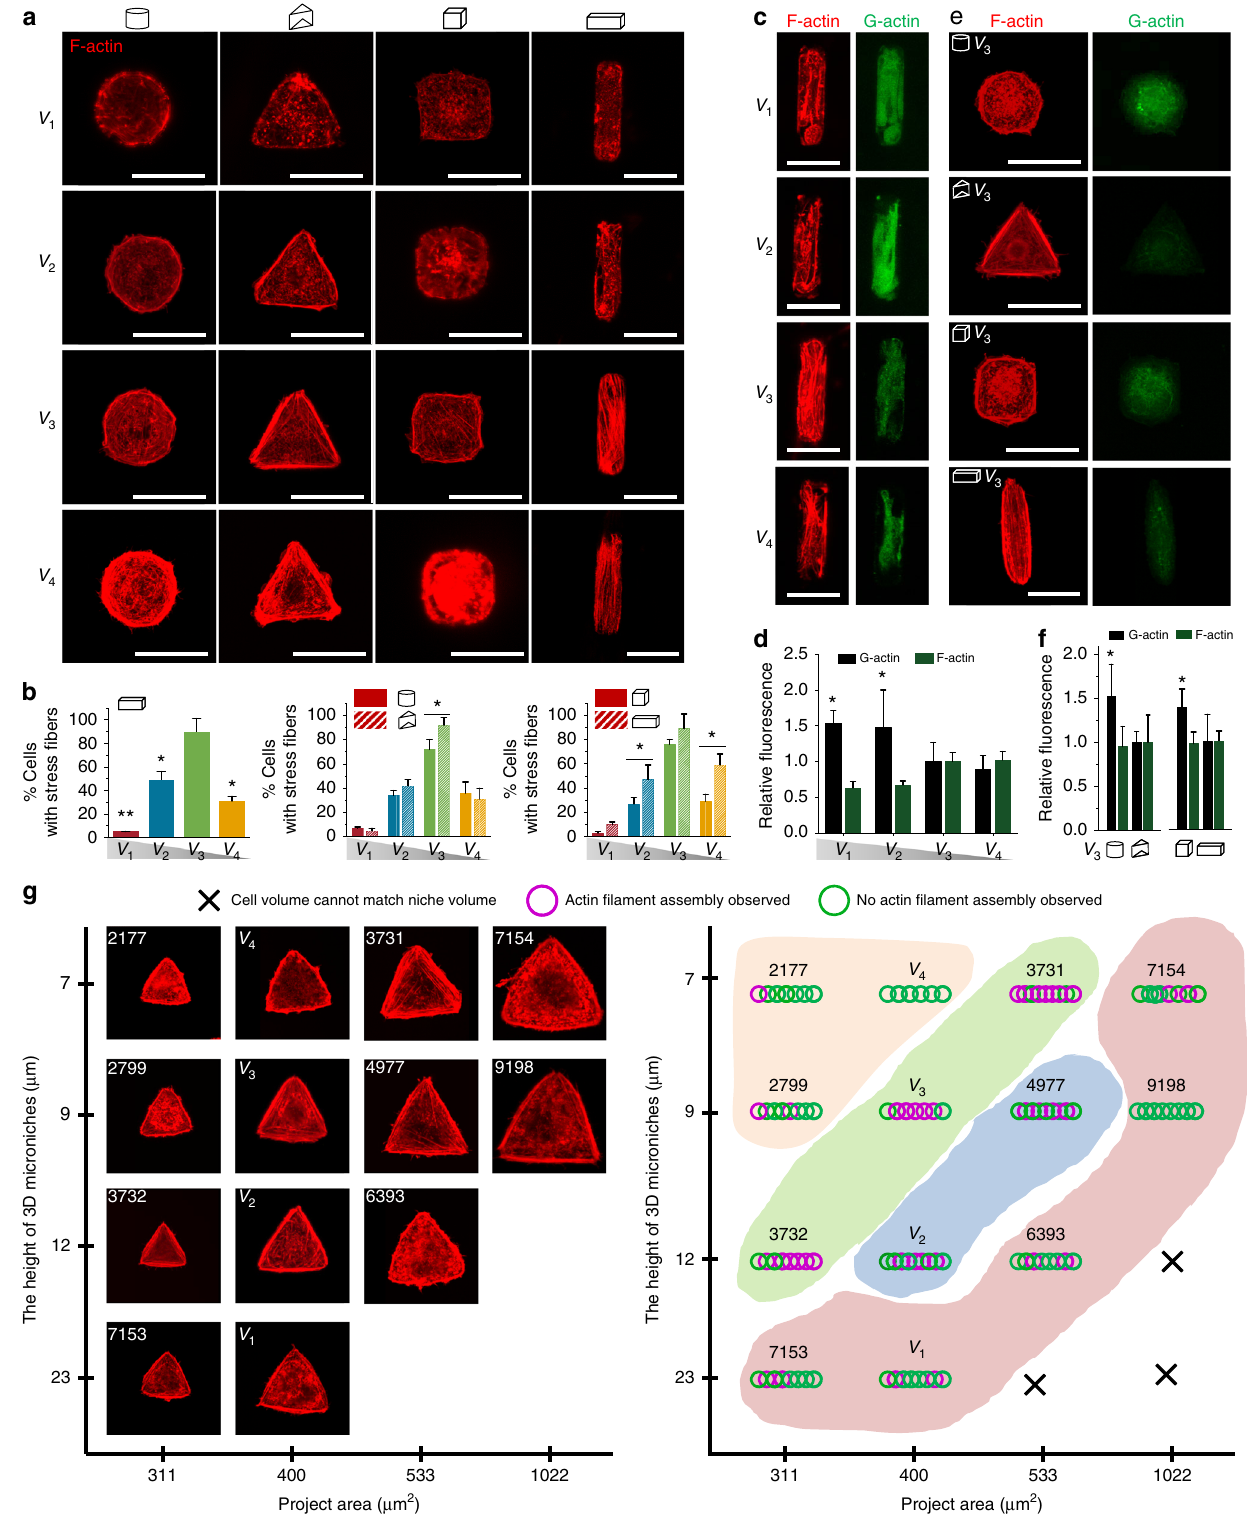
stress fi bers, and little organization of the cytoskeleton — in geometries, but the same height (9 µ m), where the project area of contrast to the original V 3 microniches with a 400 µ m 2 project 400 µ m 2 corresponds to the original V 3 microniches. We evaluated the cellular responses by investigating stress fi ber area (Supplementary Fig. 11a and b). To further con fi rm that cell formation (Supplementary Fig. 11). We found that when the volume, and not aspect ratio, project area, or shortest axis, is the project area (and corresponding volume) was too large (1022 and main factor in determining actin fi laments formation in 3D, we 533 µ m 2 ) or too small (311 µ m 2 ), F-actin staining showed few mapped the stress fi ber formation in cells seeded in microniches NATURE COMMUNICATIONS | 8: 1962 | DOI: 10.1038/s41467-017-02163-2 |